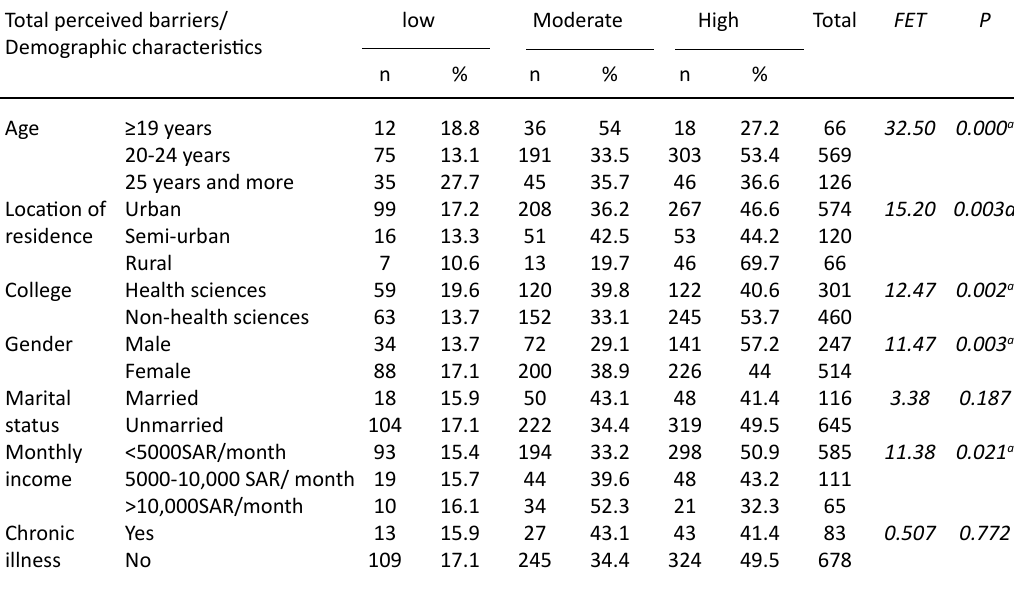
table 4. Relationship between subject total perceived barriers and their demographic characteristics (n=761) Total perceived barriers/